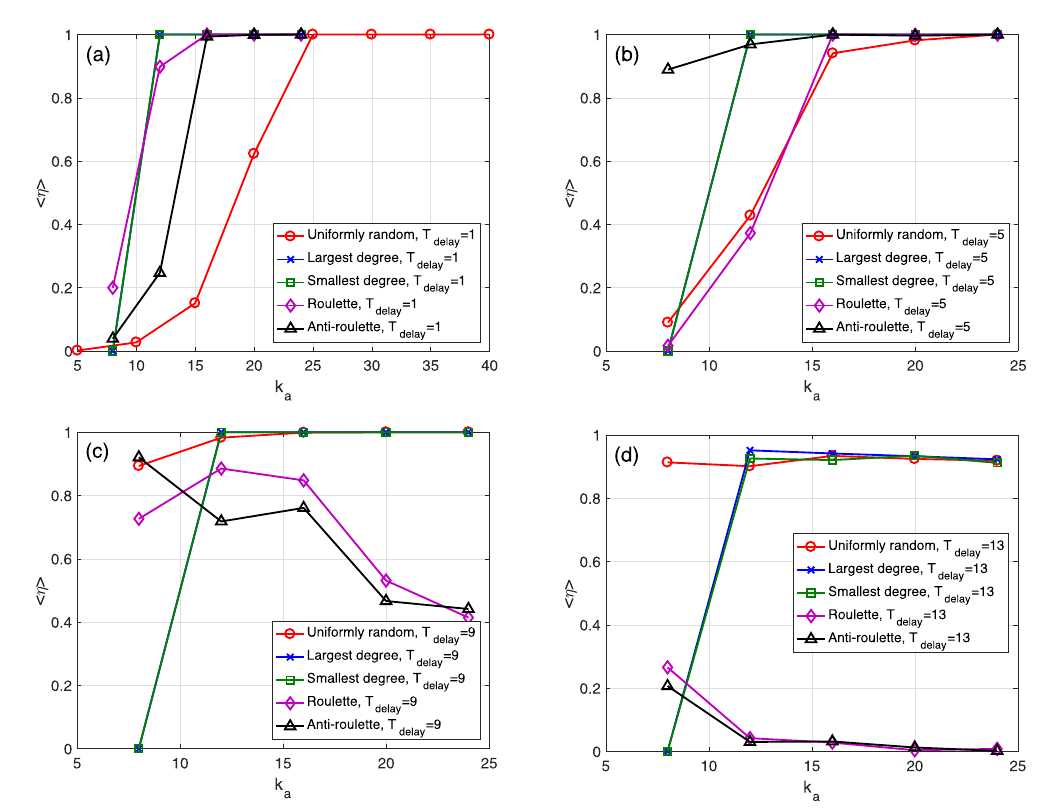
Figure 6. Mean survival ratio 〈 η 〉 as a function of k a for N a = 100. ( a ) Different selection rules for the SF network case with T delay = 1. N = 1000, M = 3000, M a = 10, γ = 1.8, k s = 5, q = 0.39, and f = 0.2. The threshold for determining a total collapse is d = 0.1. ( b–d ) Similar to (a) but for T delay = 5, T delay = 9, and T delay =